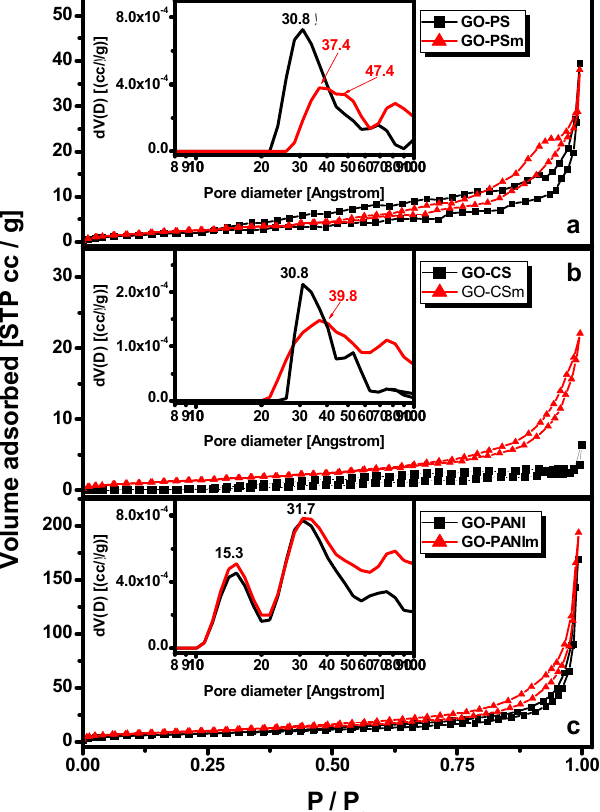
Figure 2. N 2 adsorption–desorption isotherms and pore size distribution (inset figures). ( a ) GO-PS and GO-PSm; ( b ) GO-CS and GO-CSm; ( c ) GO-PANI and GO-PANIm.